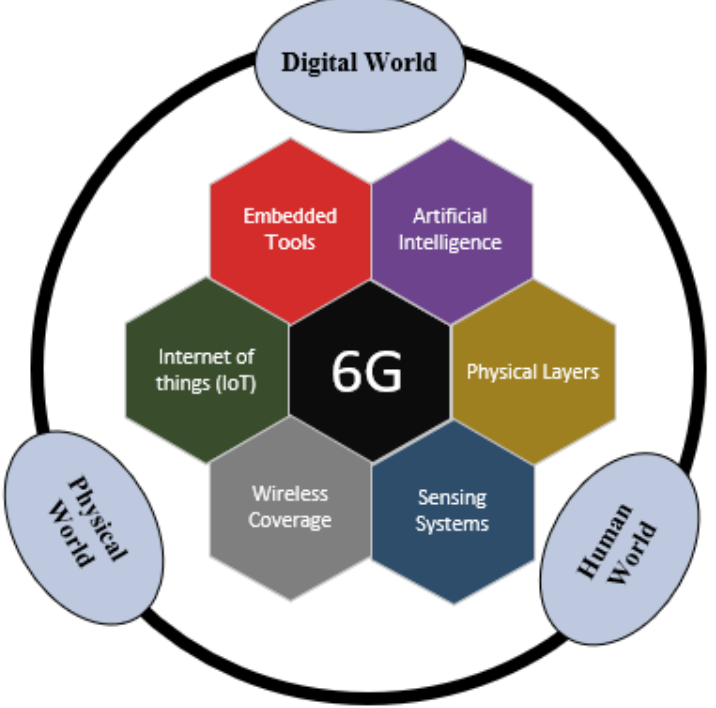
Figure 1. The possible framework of 6G [21] .